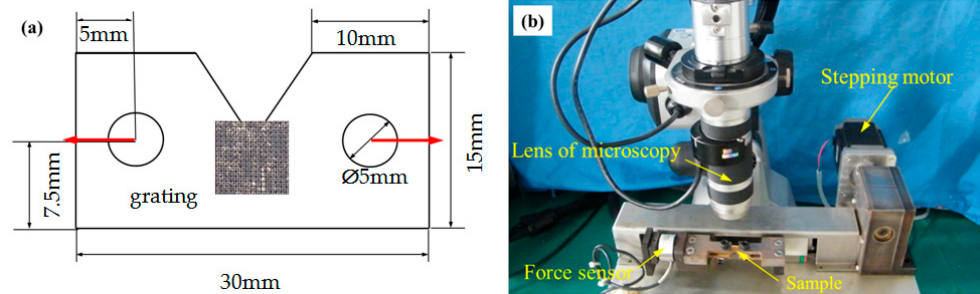
Figure 3. ( a ) Schematic of the polymethyl methacrylate (PMMA) specimen and ( b ) the experimental setup including an optical microscope and a tensile loading stage.